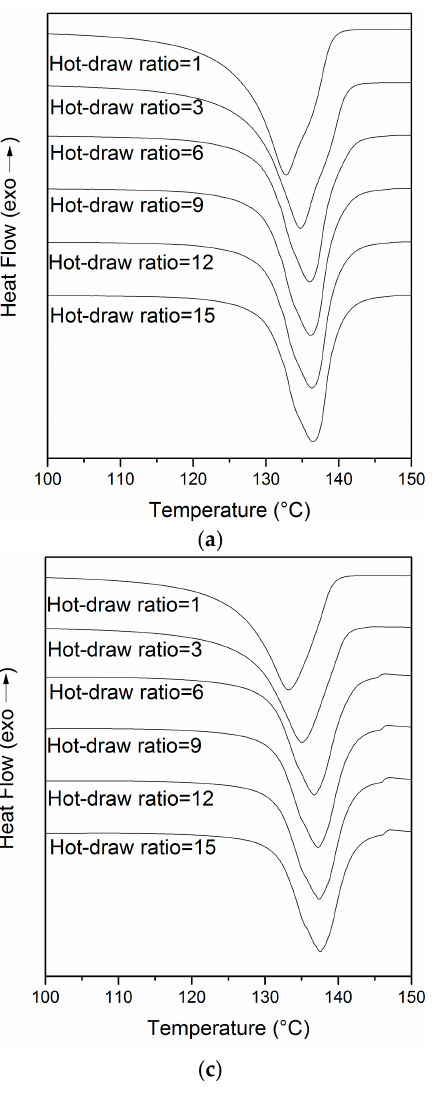
Figure 7. DSC thermograms of fibers with different draw ratios: ( a ) the first heating curves of the U/H blend fiber samples; ( b ) the second heating curves of the U/H blend fiber samples; ( c ) the first heating curves of the U fiber samples; and ( d ) the second heating curves of the U fiber samples.